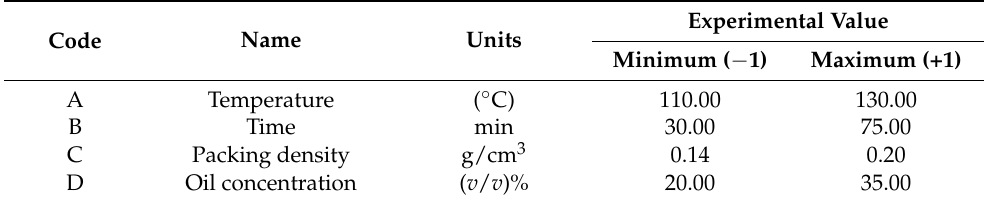
Table 1. Experimental values and levels of independent variables tested in Plackett Burman design